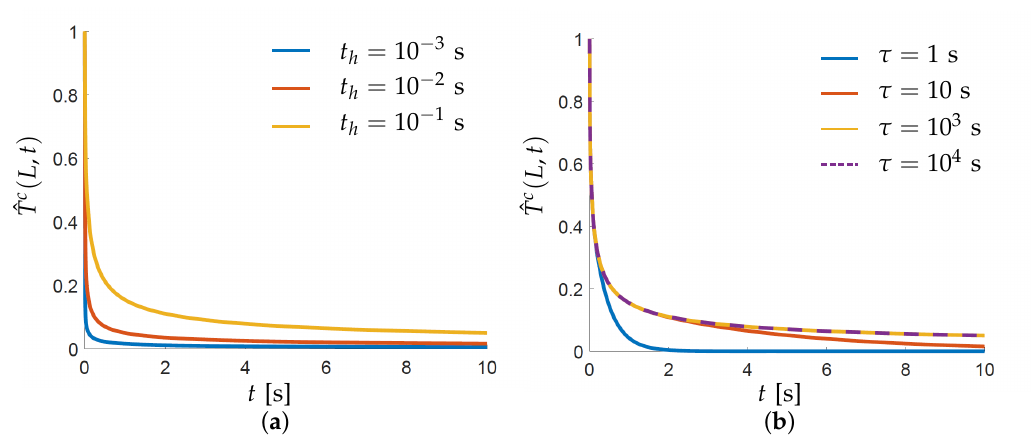
Figure 8. Variation of normalized cooling temperatures ˆ T c with respect to time as given by Equation (19) for the considered one-dimensional rod illustrated in Figure 7a. ( a ) Plots for different values of heating time t h for τ = 10 4 s. ( b ) Plots for different values of characteristic time τ for t h = 0.1